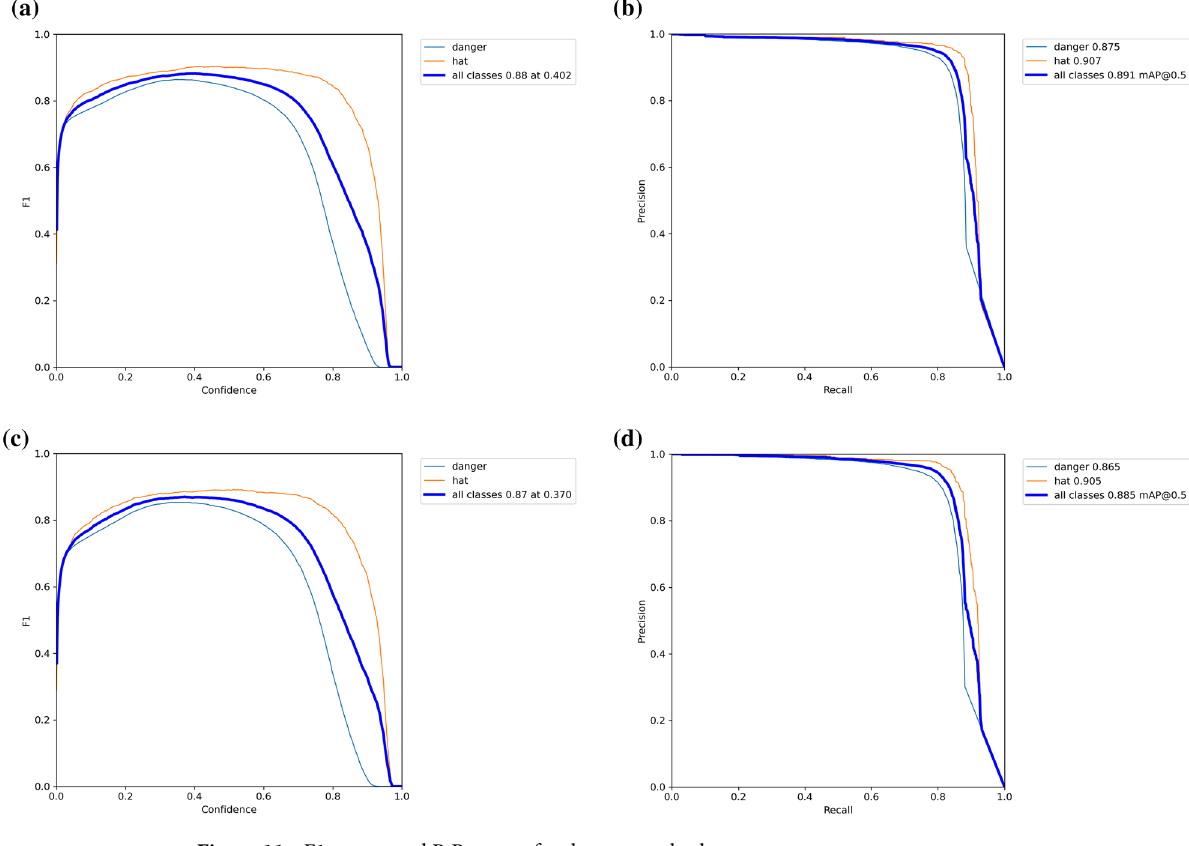
Figure 11. F1-scores and P-R curves for the two methods.